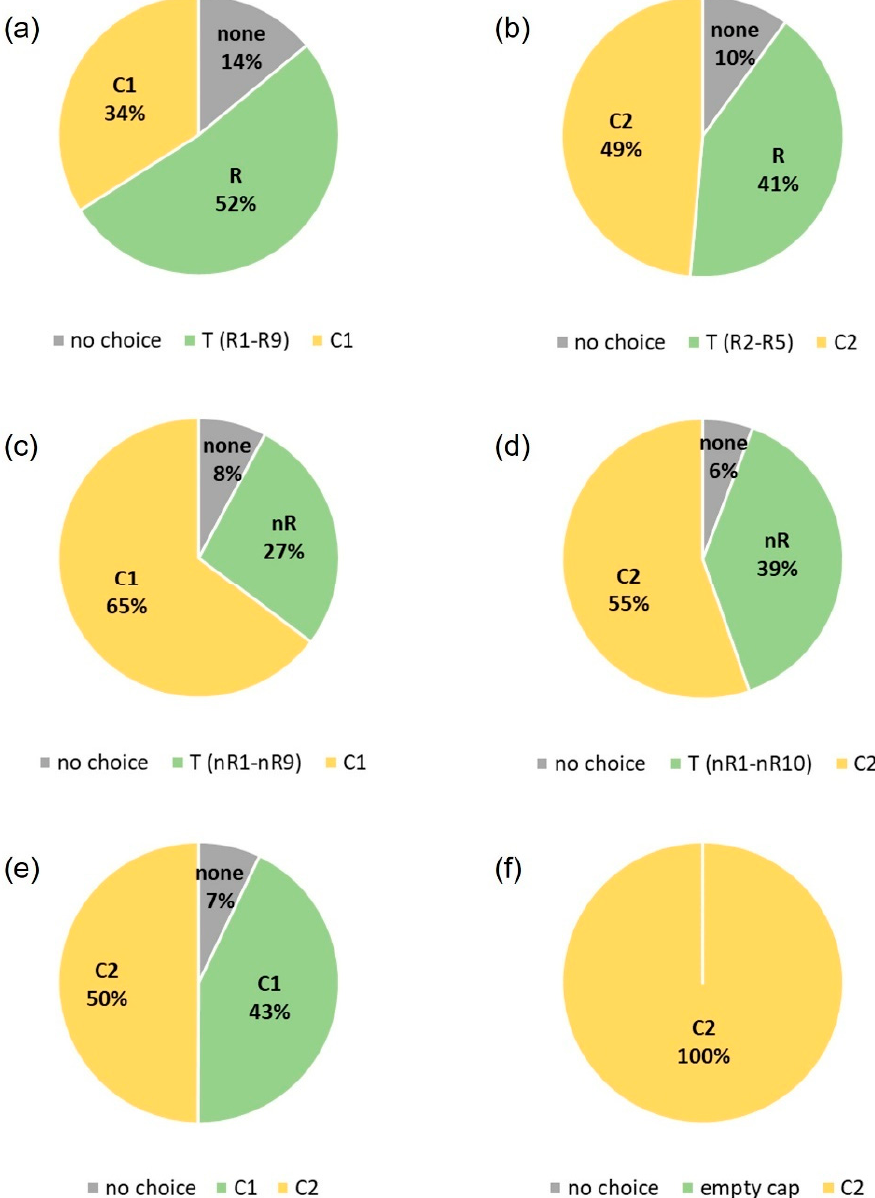
Figure 3. Proportions of “T”, “C” and “no” choices in Petri dish arena choice experiments when male Ips typographus test beetles were offered bark cores from: ( a ) roofed (T = R) and C1 trees; ( b ) roofed (T = R) and C2 trees; ( c ) non-roofed (T = nR) and C1 tress; ( d ) non-roofed (T = nR) and C2 trees; ( e ) control C1 and C2 trees; ( f ) C2 trees against an empty cap (zero tests).